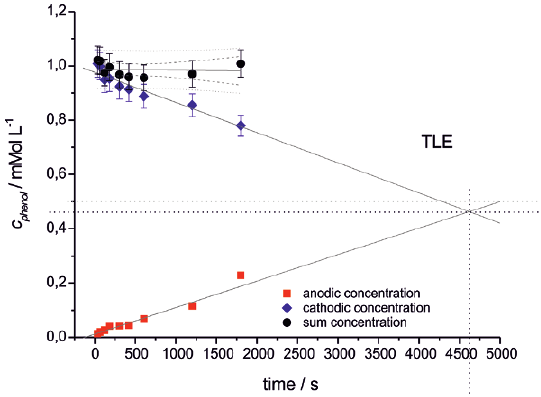
Figure 4. Exp. 1b: Transport of phenol from anodic to cathode beaker. The grey dashed line marks the theoretical mixture concentration (0.5 mmol L -1 ); the black dashed lines show concentration and time at the theoretical linear equilibrium (TLE). The concentration sum is evaluated with a linear fit including 95% confidence (dashed) and 95% prediction (dotted)